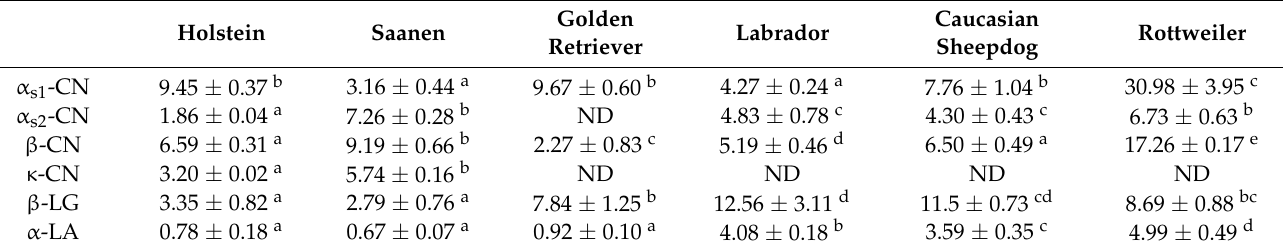
Table 2. Concentration of milk proteins of canine, bovine, and caprine milk (mg/mL). Caucasian Golden Labrador Holstein Saanen Sheepdog Retriever